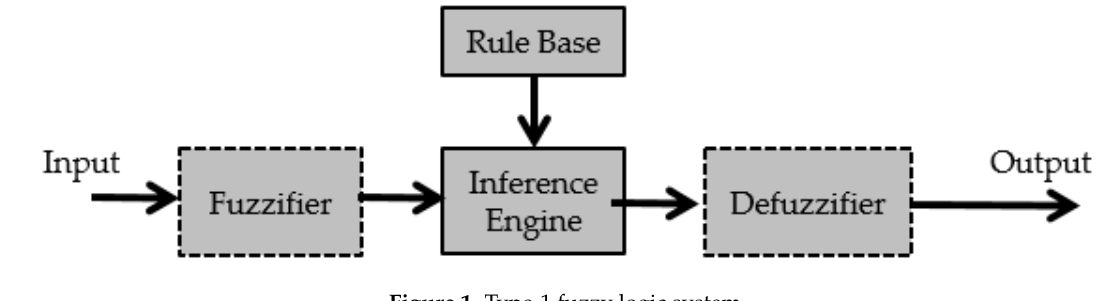
Figure 1. Type-1 fuzzy logic Figure 1 . Type-1 fuzzy logic system.